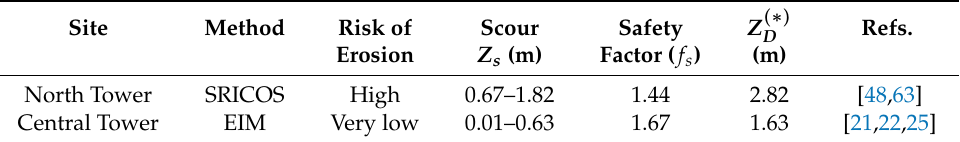
Table 6. Range of scour depth Z s and final scour depth value Z D adopted at NT and CT. ( ∗ ) Estimated considering Equations (25) and